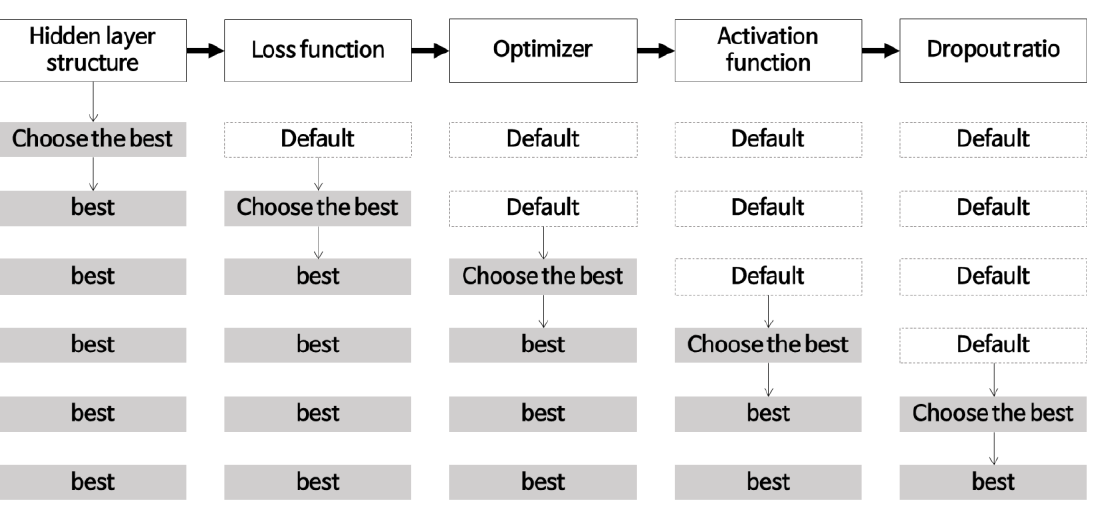
Figure 3. Parameter optimization process for a deep neural network (DNN) model in this study.